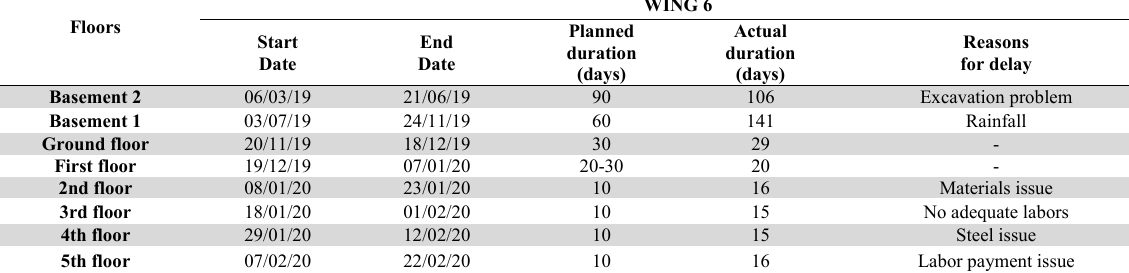
Planned and Actual Duration of Wing 6